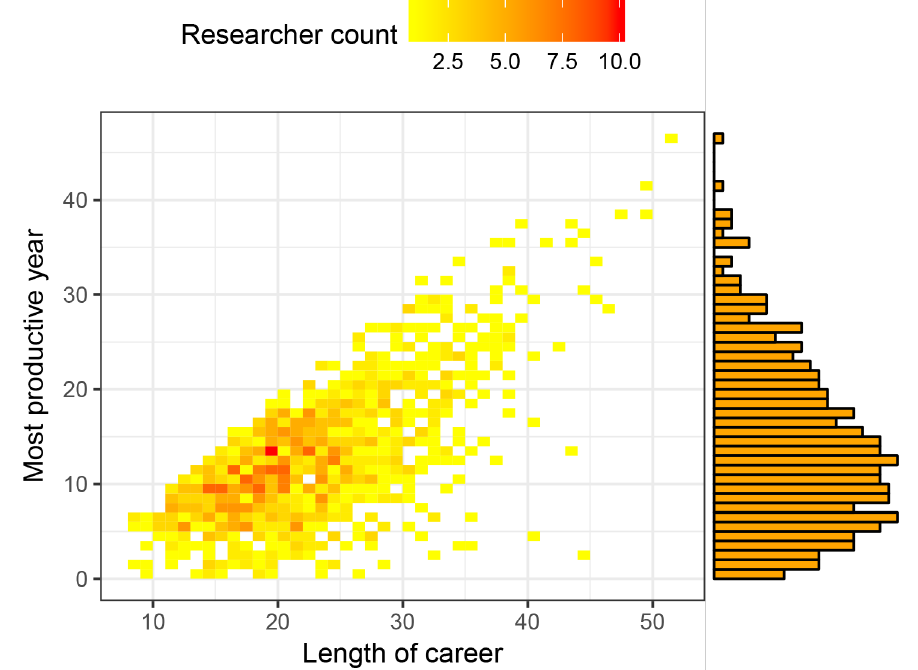
Figure 7 - Heat map of the peak-year for the 1000-most productive researchers in the Brazilian Computer Science community.